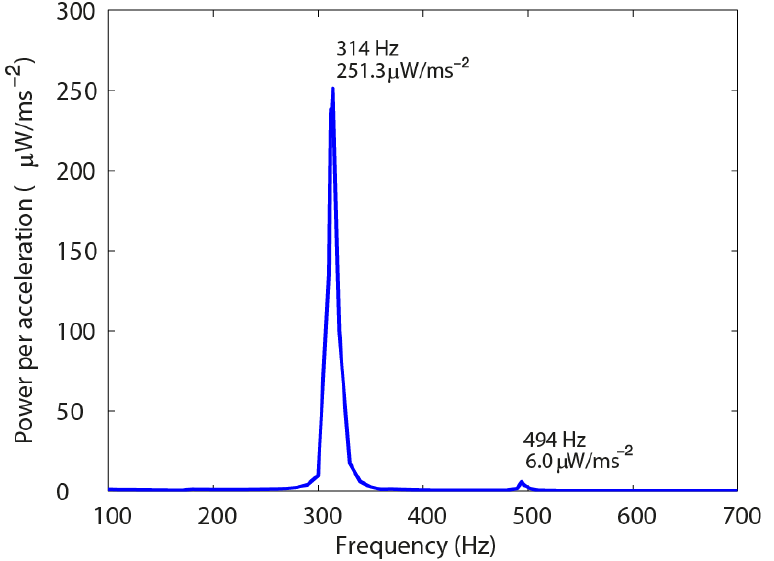
Figure 13. Output power per base acceleration as a function of the excitation frequency.